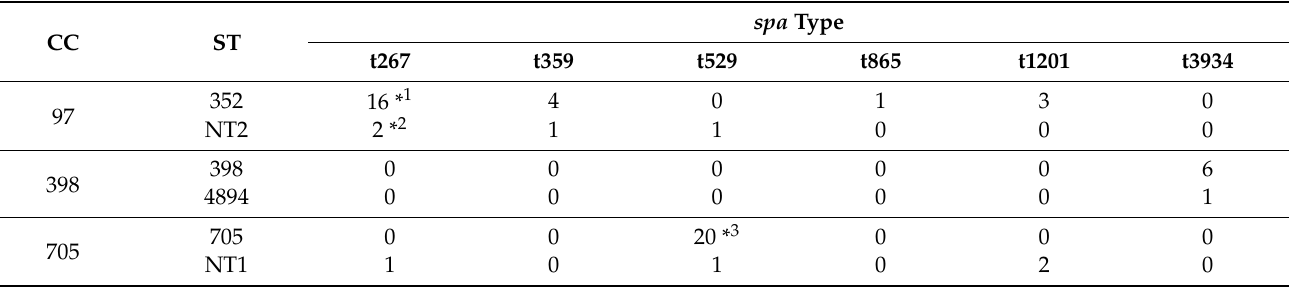
Table 2. Correlation of genetic typing (CC and ST) and spa type.